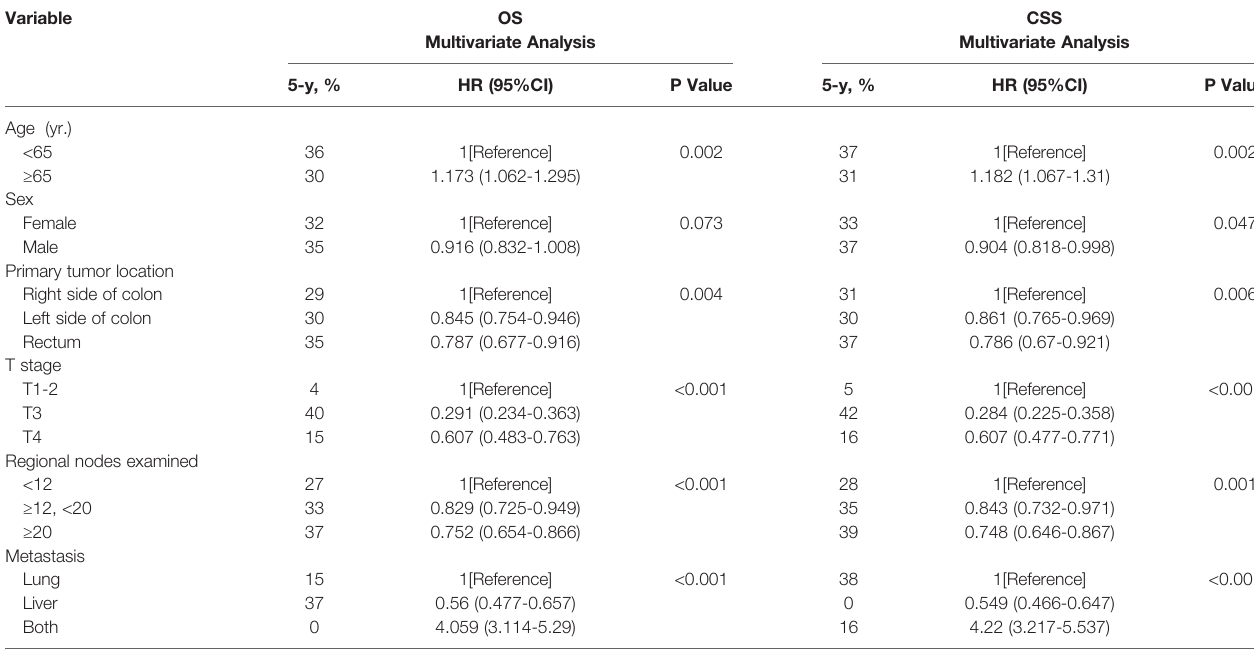
TABLE 3 | Multivariate analysis of the prognostic factors of OS and CSS after resection of LM and/or PM in CRC. Variable